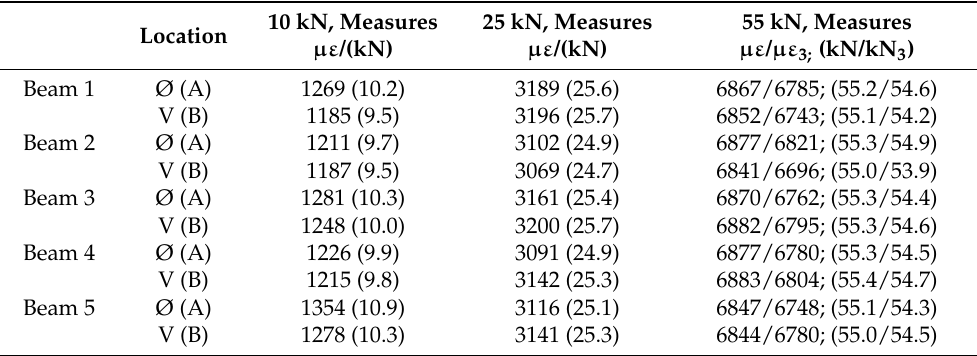
Table 4. Measured pre-stressing values during Phase 1, measured in microstrain with kilonewtons in parenthesis. In the final pre-stressing level, initial values are given along with measurements after three hours.